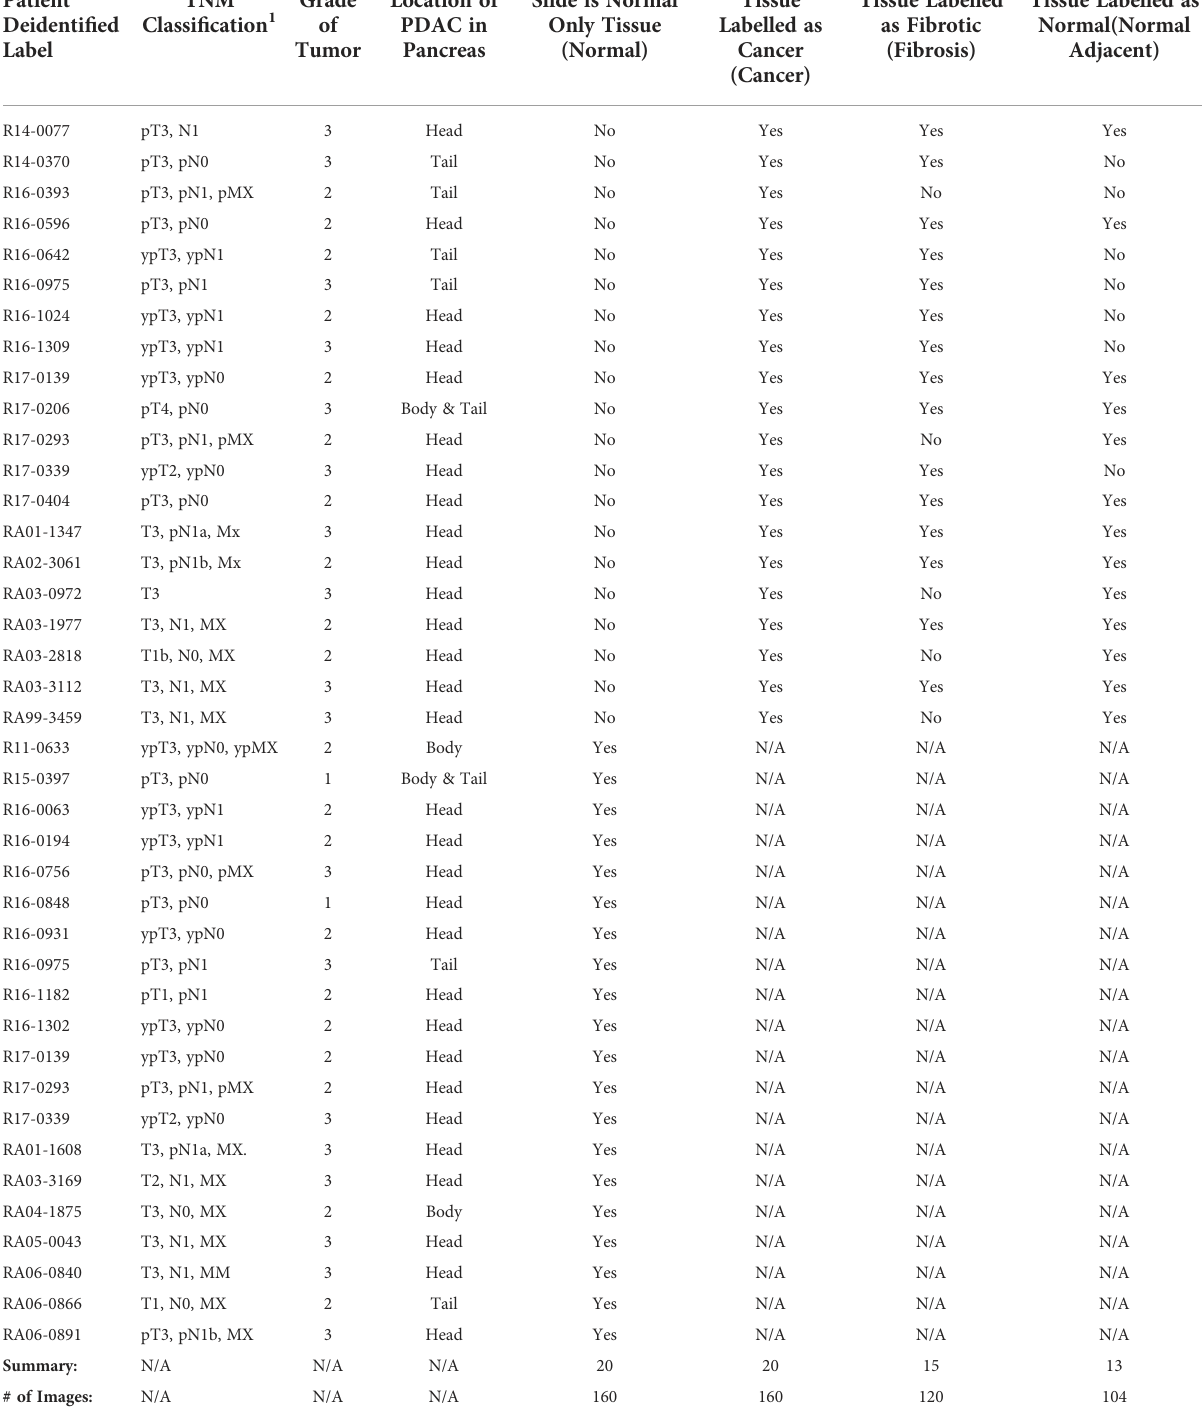
TABLE 1 Summary of pancreatic biopsy slide information by patient. Patient Deidenti fi